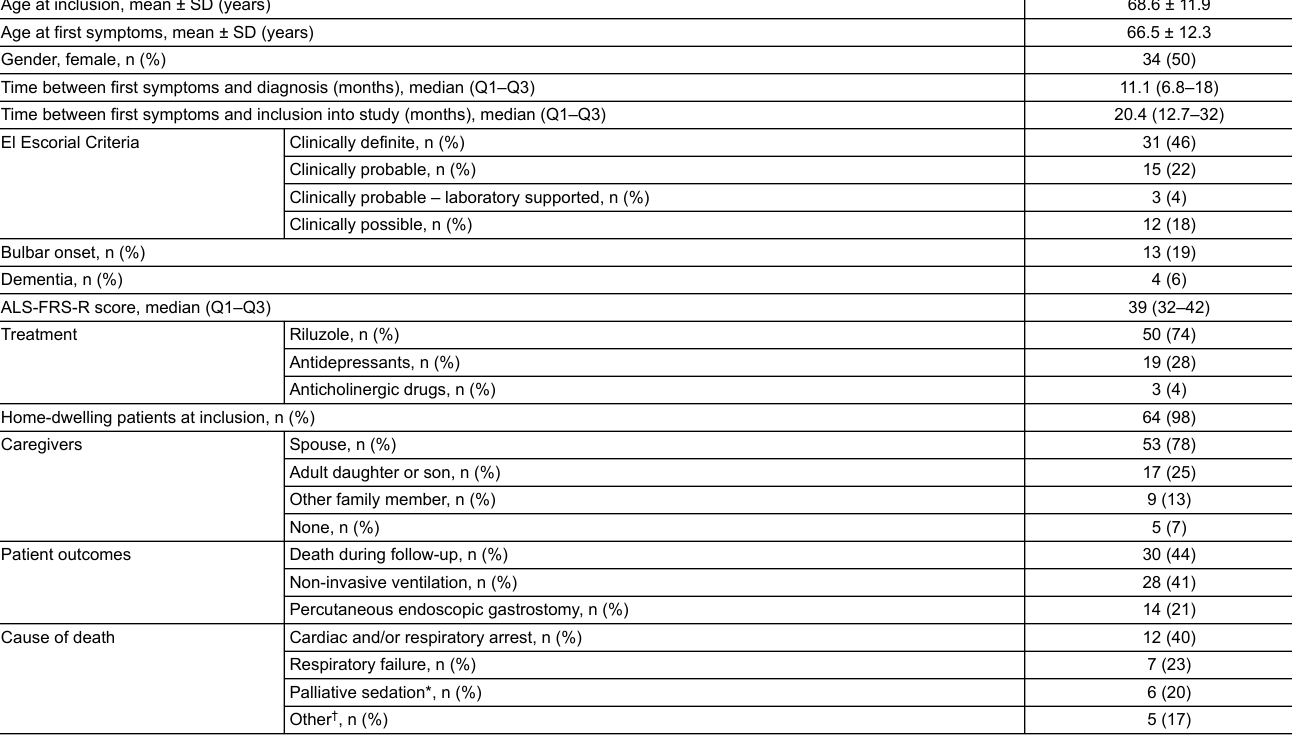
Table 2: Baseline characteristics of patients (n = 68) in the ALS cohort at inclusion and major outcomes. Age at inclusion, mean ± SD (years)